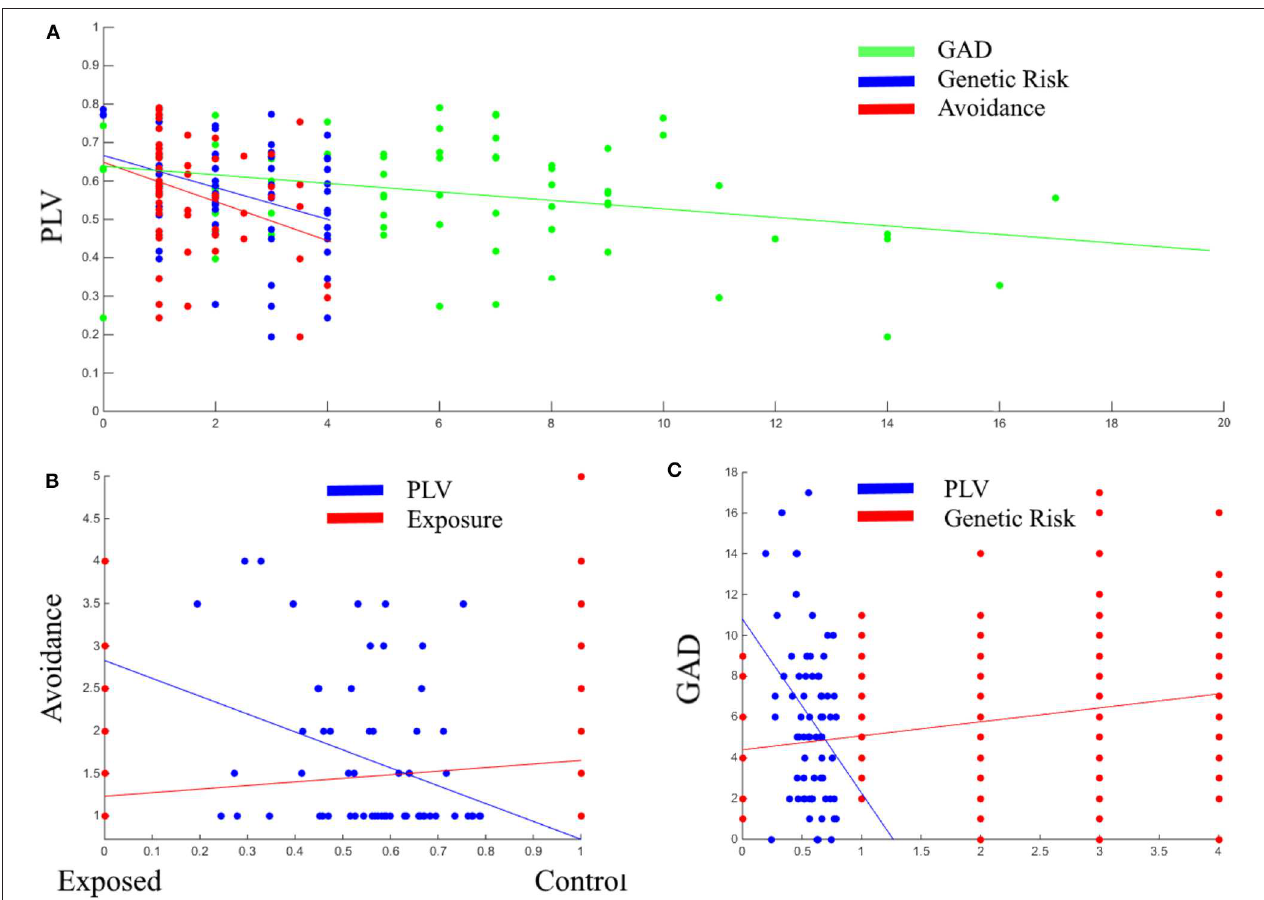
FIGURE 4 | Scatter plots between PLV, GAD, genetic risk, and avoidance (A) ; Between avoidance, PLV, and exposure (B) ; Between GAD, PLV, and genetic risk (C) . PLV, Phase locking value; GAD, General anxiety disorder scores; Genetic Risk, cumulative genetic risk. Linear lines are regression lines (between the variable on axis Y and the variable in the same color as the regression